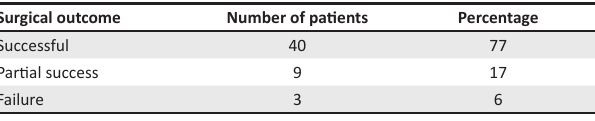
TABLE 4: Surgical results in three subgroups (successful, partial success and failure) as numbers and percentages of the total study group. Surgical outcome